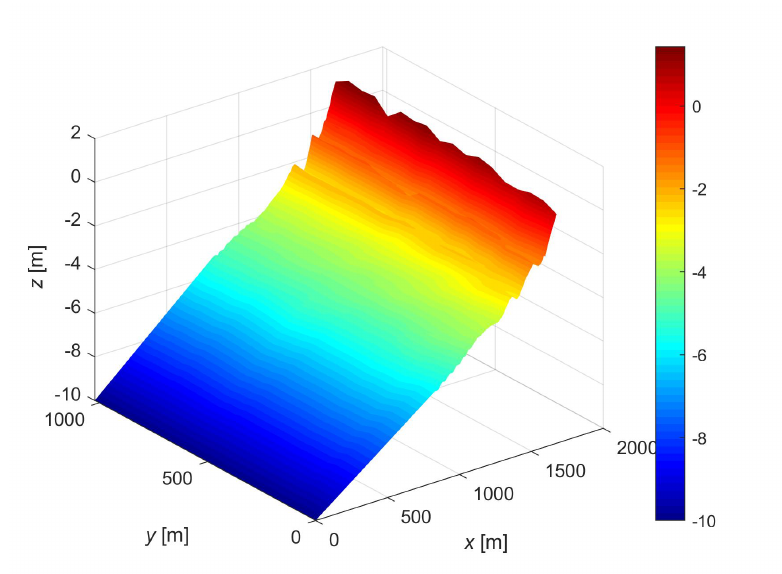
Figure 2. Original ground-truth bathymetry used for the baseline